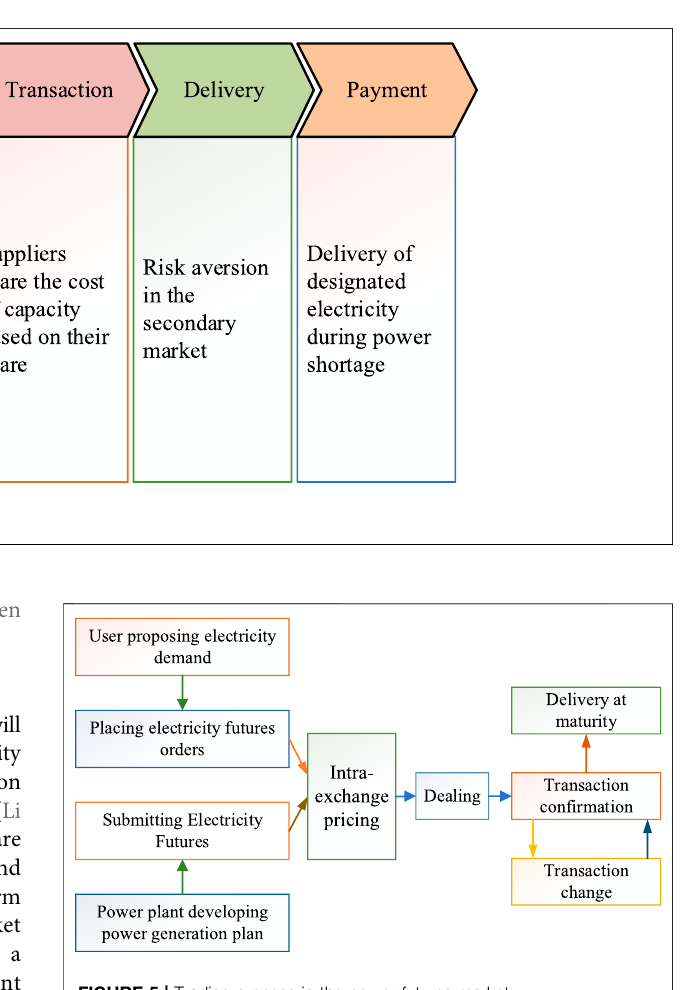
FIGURE 5 | Trading process in the power futures